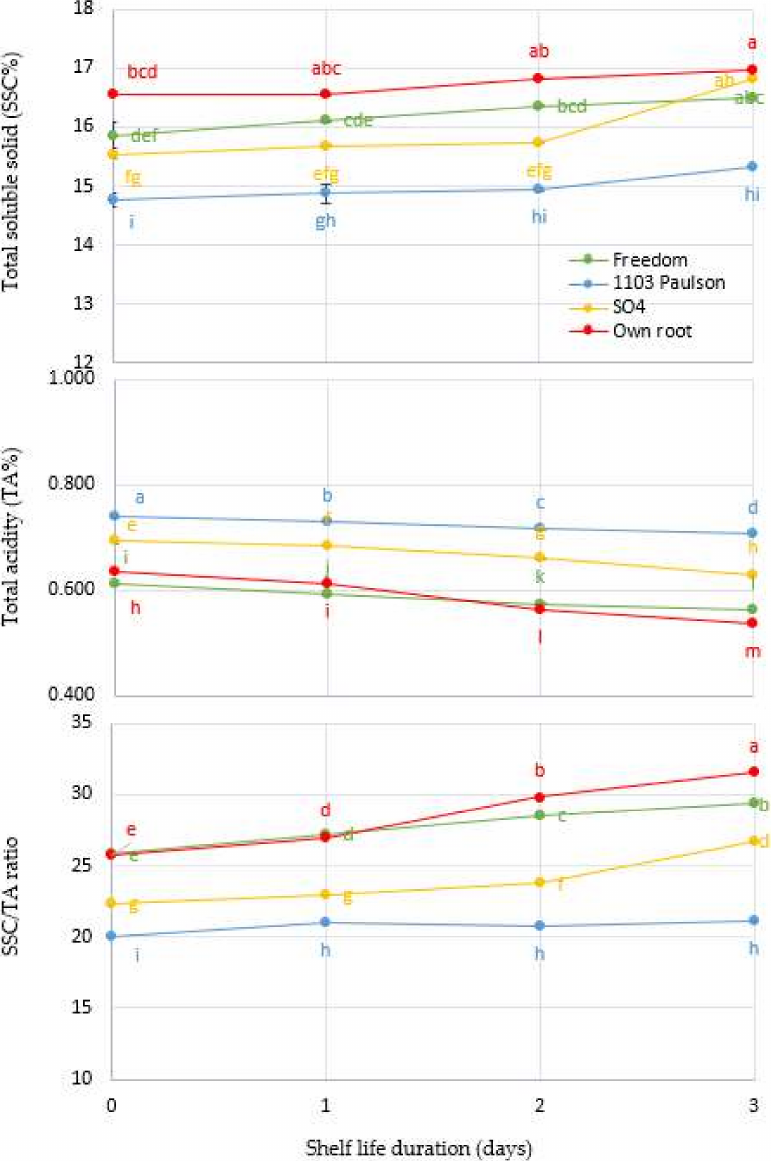
Figure 3. Interaction between Superior Seedless grapevine rootstocks (Freedom, 1103 Paulsen, SO 4 , and Own Root) and shelf life in days and effect on total soluble solids concentration (SSC%), total acidity (TA%), and SSC/TA ratio during three days of shelf life (27 ± 1 ◦ C with 57 ± 3% RH). Significantly different samples, according to Tukey’s HSD test at 5%, are indicated by different letters. The 1103 Paulsen rootstock is genetically related to Fame Seedless (scion), which is most likely the cause of the increase in TA% [10]. Since the metabolism of